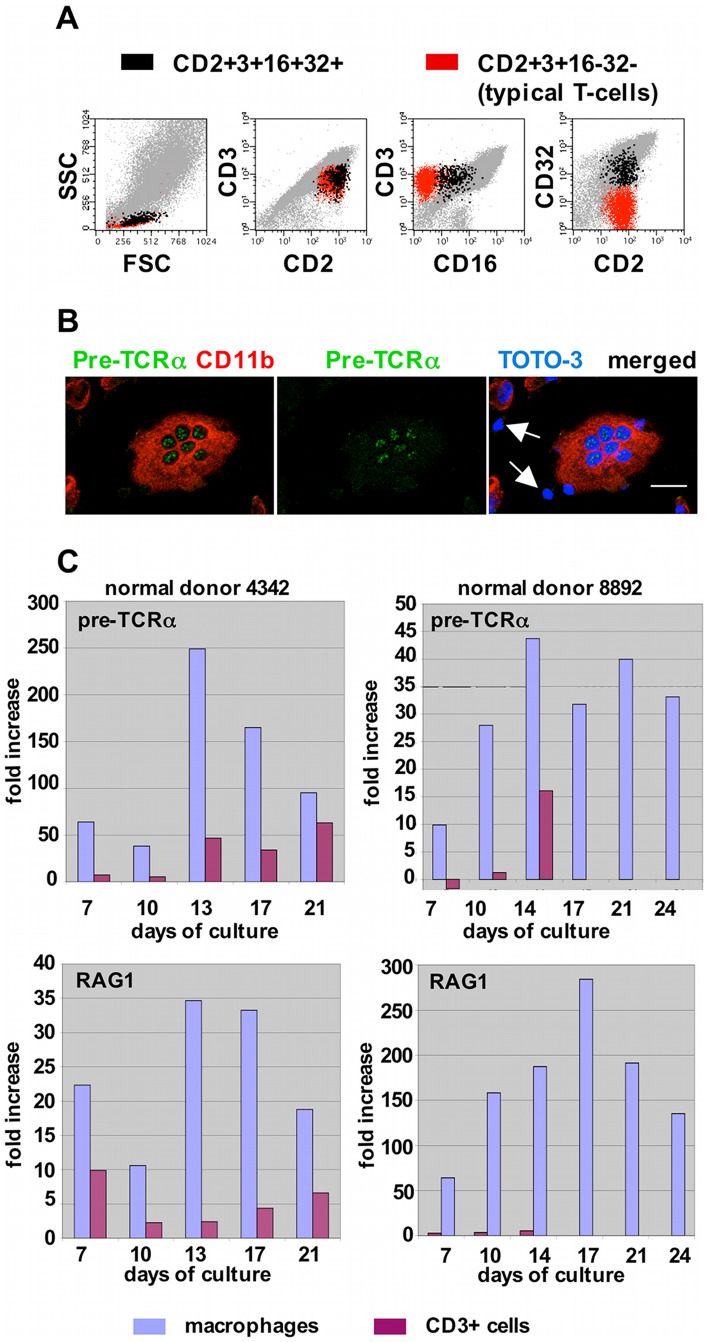
Markers of T-cell immaturity in nurse macrophage-derived T-cells and within nurse macrophages.(A) Detection of CD16+CD32+ T-cells among the nonadherent population harvested at day 21 from primary MDM cultures. At this time, the CD16+CD32+ population represented 6.5% of the total CD3+ cells (also see Table 1). (B) Expression of pre-TCRα associated with nuclei within a nurse macrophage from a 13-day-old primary culture. (Primary cultures do not contain IL-2.) Arrows in the right panel indicate CD11b-negative cells, presumed to be T-cells, not expressing pre-TCRα. Size bar: 20 µm. (C) Expression of pre-TCRα and RAG1 in macrophages and CD3+ cells recovered from primary macrophage cultures, as determined by real-time PCR. CD3+ cells were purified from the nonadherent populations using CD3+ magnetic beads. Macrophages were harvested using accutase. GAPDH was used as a housekeeping gene to normalize values. For each donor, the mean values obtained from uncultured CD3+ cells were subtracted from the mean values shown for CD3+ cells at each time point, and similarly, the mean values obtained from uncultured CD14+ cells were subtracted from the mean values obtained for the cultured macrophages at each time point. No values are shown for CD3+ cells for donor 8892 at days 17, 21 and 24, because too few nonadherent cells were recovered to permit CD3+ magnetic bead selection. The average percent difference between replicate reactions was 0.5% (donor 4342) and 1.3% (donor 8892) for pre-TCRα, and 0.9% (donor 4342) and 0.4% (donor 8892) for RAG1.